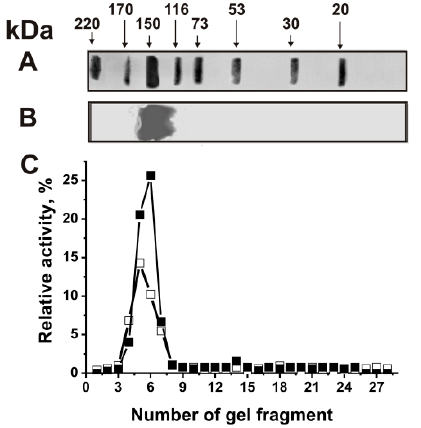
Figure 1. Panel ( A ) shows the position of molecular mass markers. The IgG mix (14 μ g) homogeneity analysis by SDS-PAGE under non-reducing conditions in the absence of thiol-disulfide reducing reagent dithiothreitol ( B ); silver staining. Panel ( B ) demonstrates the position of IgGs. The relative activities (RA, %) in the hydrolysis of five histones ( ■ ) and MBP ( □ ) were estimated using eluates of gel fragments (2–3 mm) ( C ). After incubation for 24 h with eluates, complete hydrolysis of all substrates was undertaken for 100% ( C ). The errors of the relative activities estimation from two independent experiments did not exceed